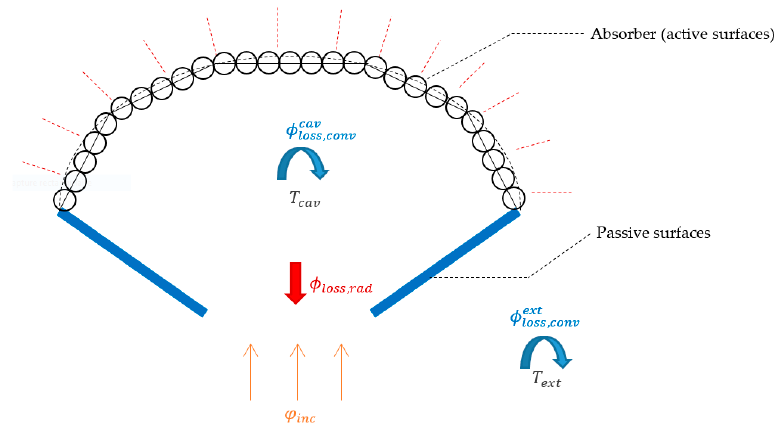
Figure 1. Schematic view of the receiver’s cavity with the different thermal fluxes. Red dashed lines indicate thermally insulated walls.